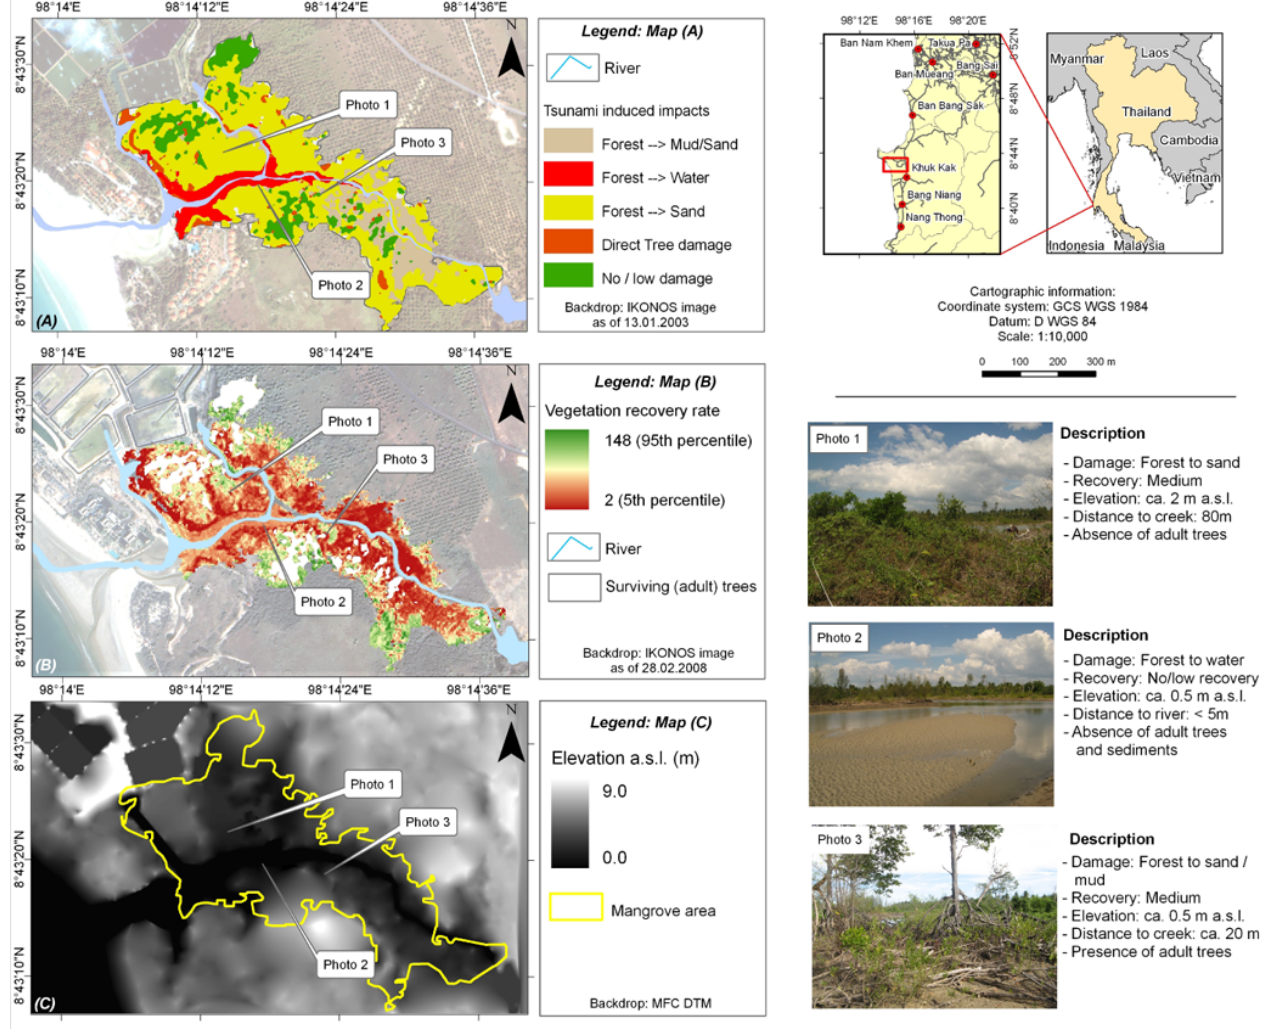
Fig. 12. Impacts and recovery patterns for a mangrove stand near Cape